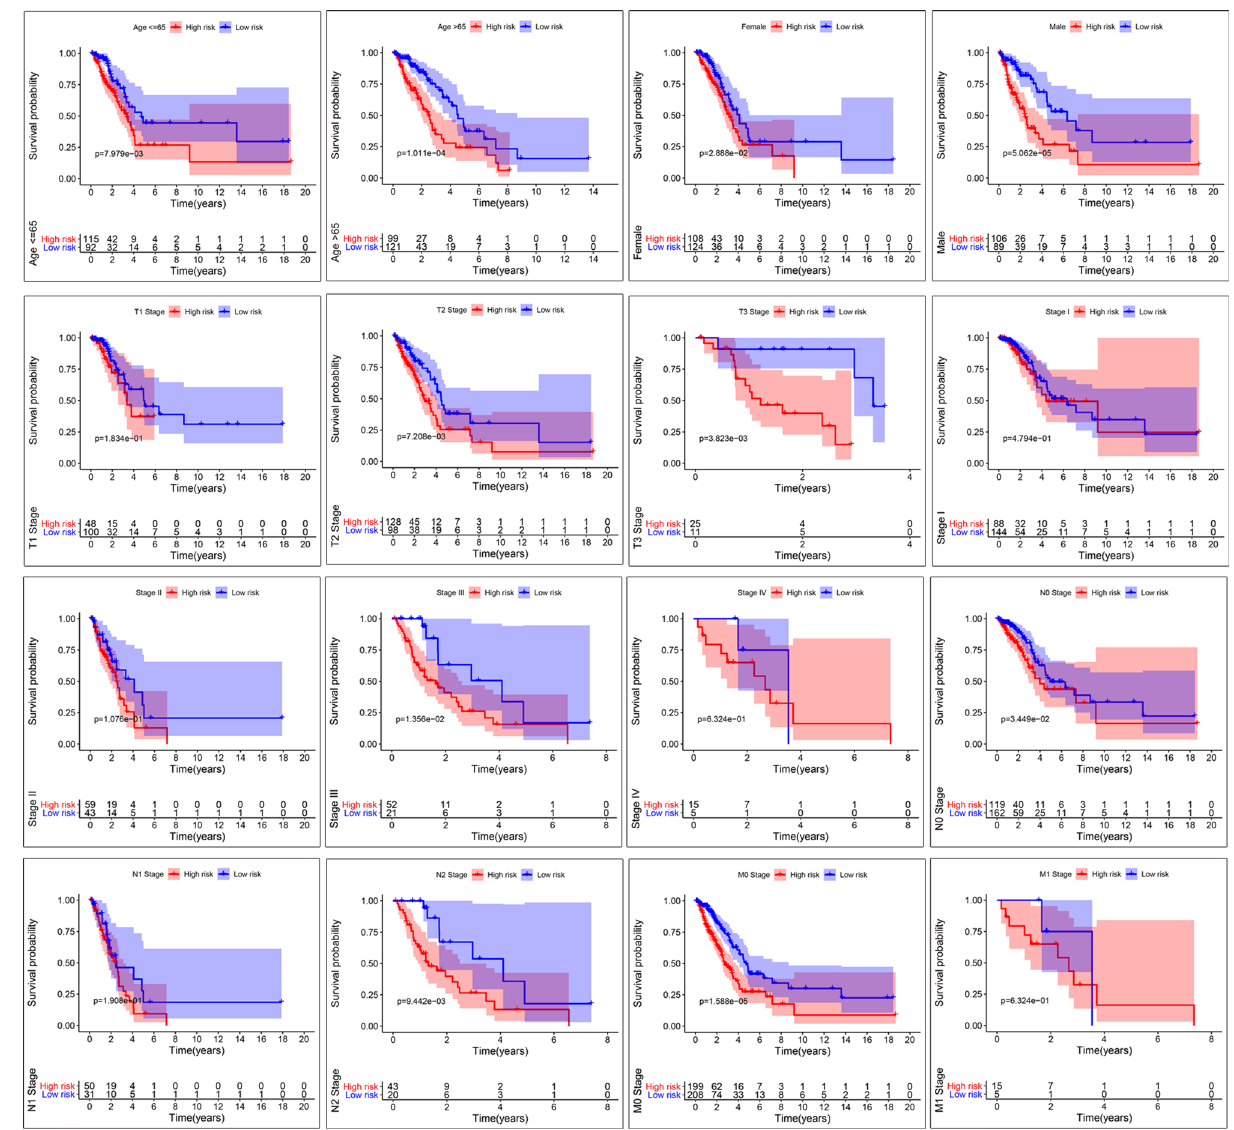
Figure 3. Subgroup analysis. Kaplan–Meier survival illustrated the overall survival of subgroups, which was stratified by age ≤ 65, age > 65, gender, and TNM